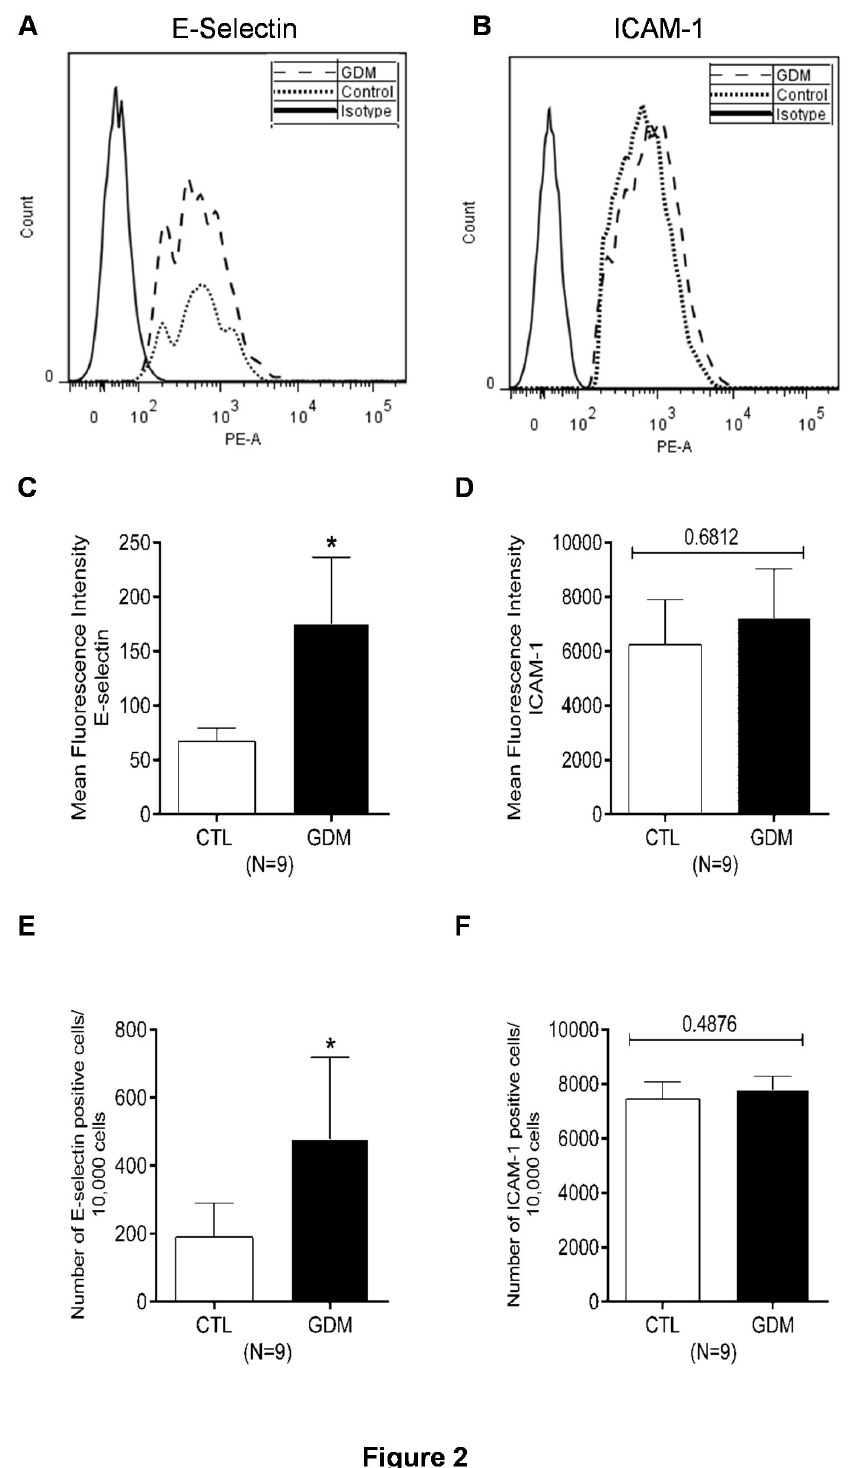
Figure 2. FACS analysis for surface expression of adhesion molecules. (A&B) Histograms depicting mean fluorescence intensity for surface expression of E-selectin and ICAM-1 in isolated HUVECs (P summarizing MFI for E-selectin and ICAM-1 for nine subjects in each group, (E&F) Bar graphs summarizing number of cells positive for E-selectin and ICAM-1 in freshly isolated HUVECs. *p≤0.05 versus control group. doi: 10.1371/journal.pone.0084546.g002 PLOS ONE |